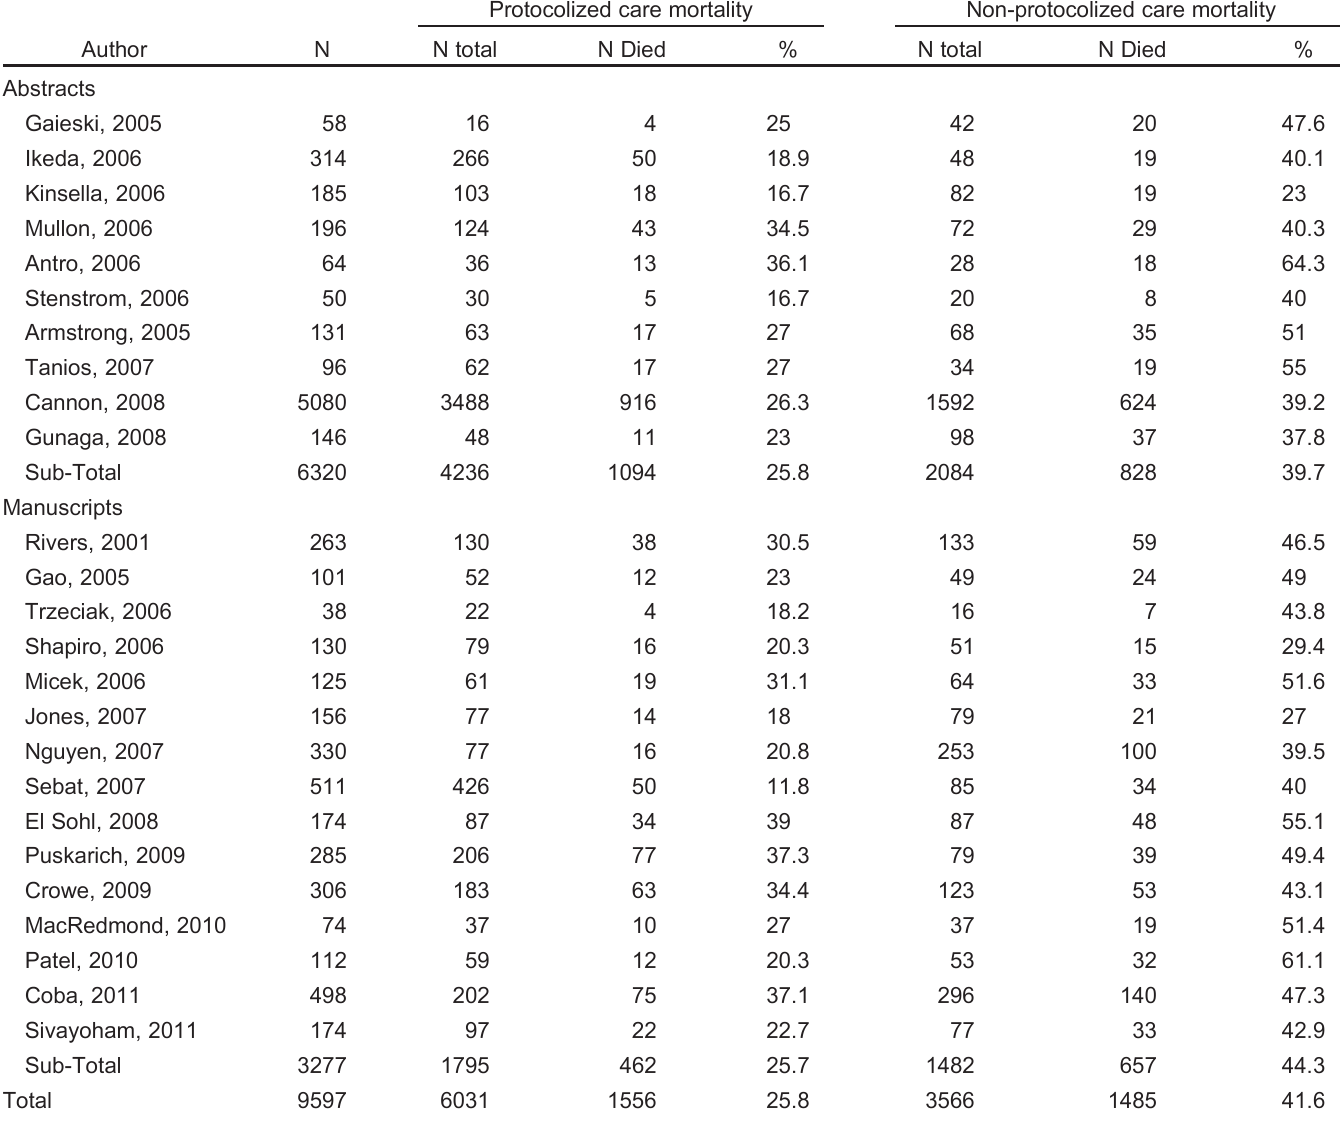
Table 1. Overall mortality for protocolized versus non-protocolized hemodynamic optimization for both published studies and published abstracts. Protocolized care